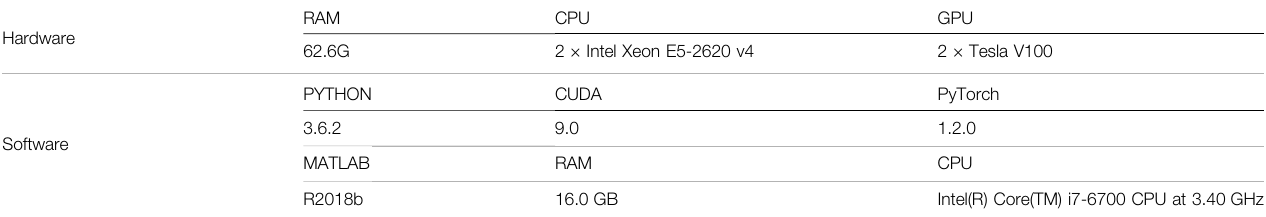
TABLE 7 | Hardware and software for experiment. Hardware